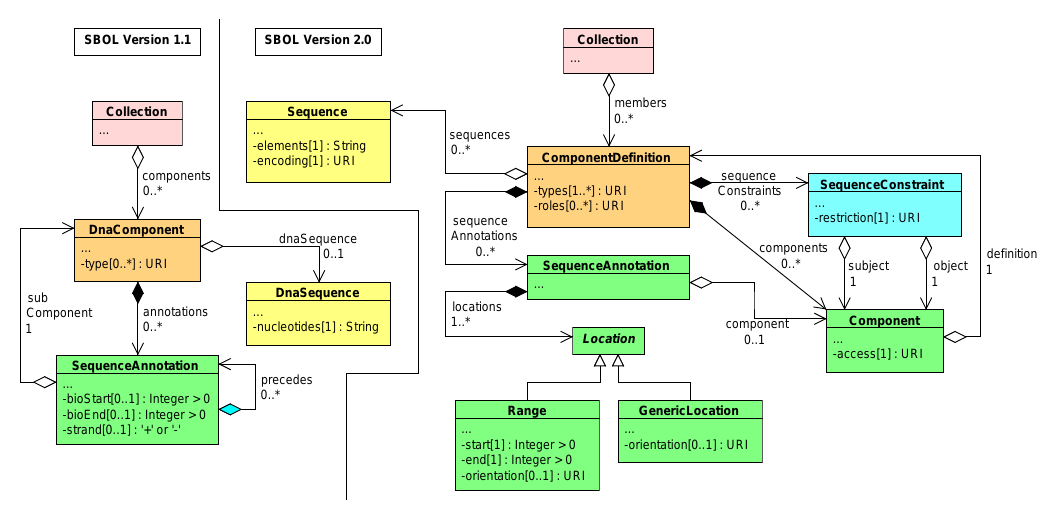
Figure 22: The mapping from the SBOL 1.1 data model to the SBOL 2.x data model, indicating corresponding class- es/properties by color.